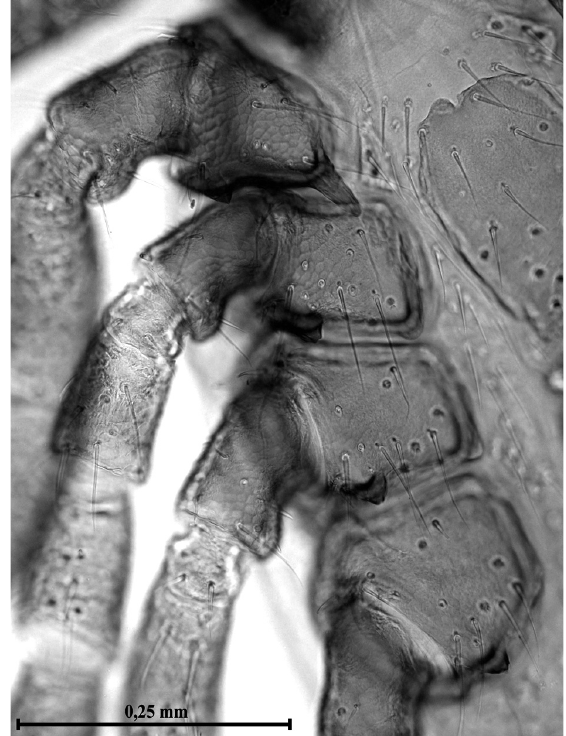
Fig. 3. – Male of Ixodes festai clarified in KOH 10 % solution and mounted in Faure’s liquid, lying dorsally. Fig. 4. – Coxae I-IV of the male of Ixodes festai